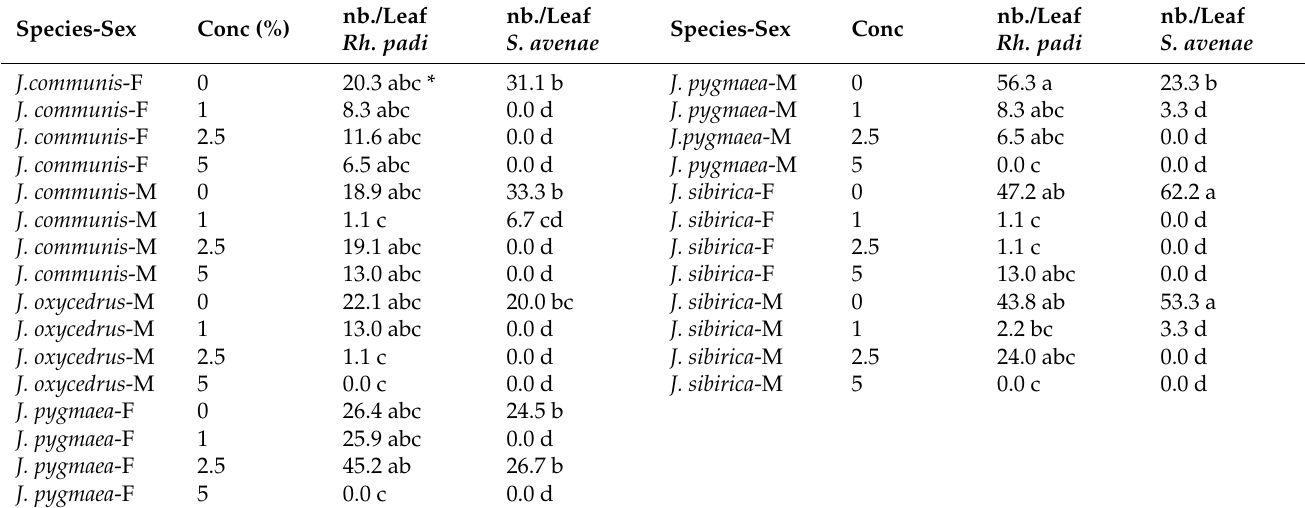
Table 6. Mean Rhopalosiphum padi and Sitobion avenae for the repellent action obtained from the 28 combinations of species-sex and EO concentration